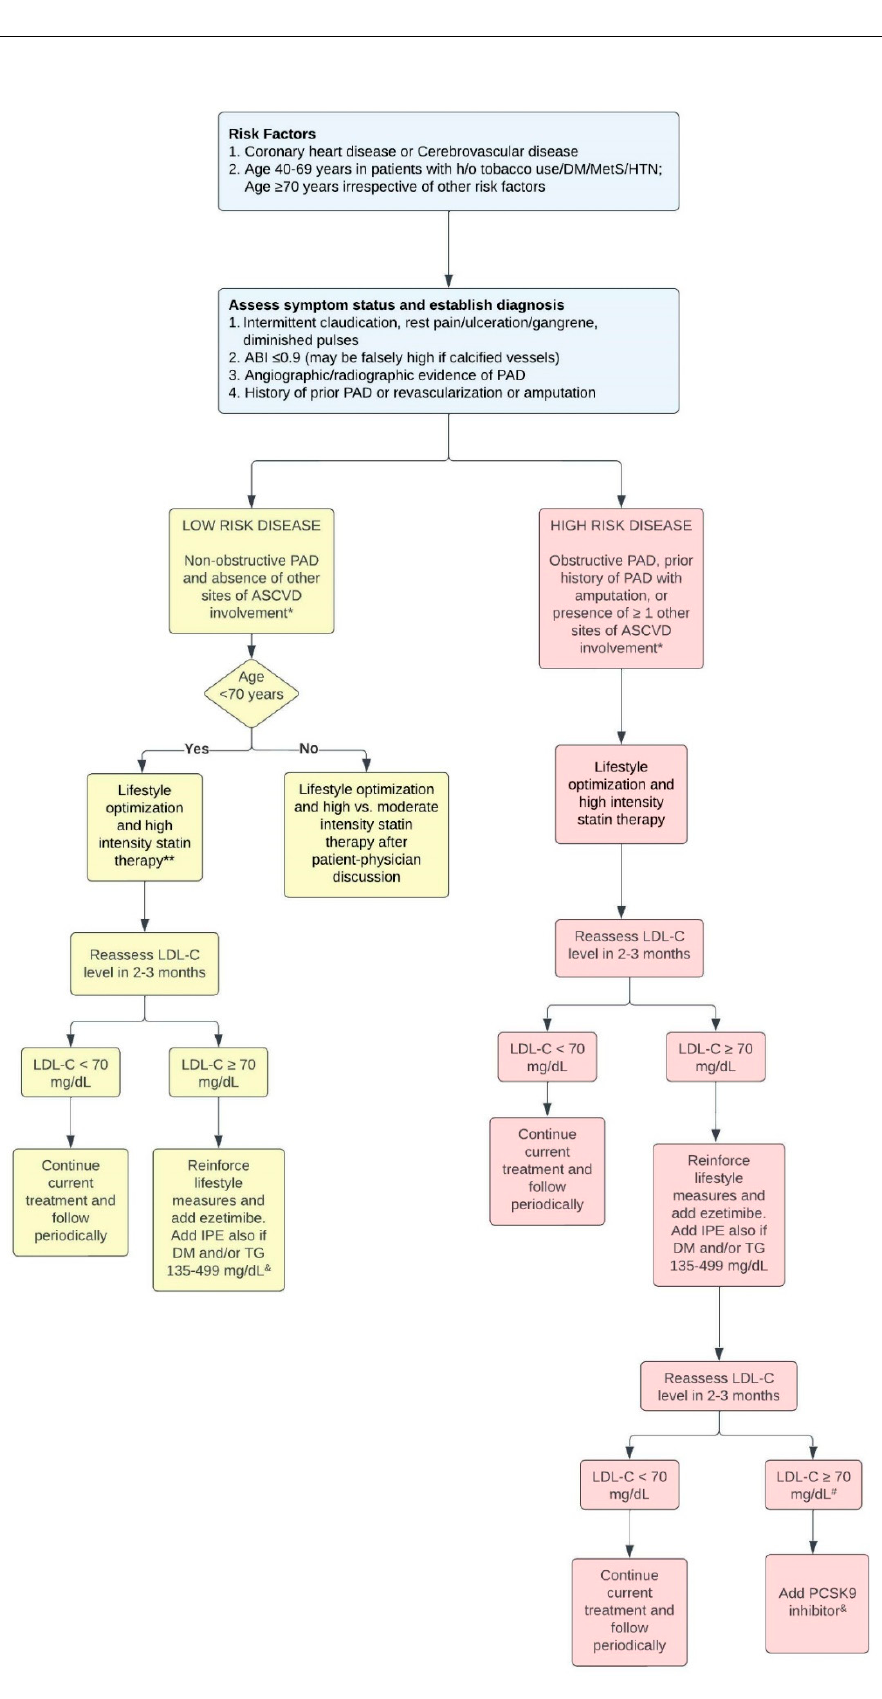
Figure 3. University of Louisville approach to PAD treatment based on current guidelines. * ASCVD disease includes CAD, PAD, TIA, stroke, history of myocardial infarction, aortic aneurysm, carotid atherosclerotic disease, history of coronary artery bypass grafting, or percutaneous coronary inter- vention. Risk factors include HTN, HLD, DM, age ≥ 70 years, LDL-C >100 mg/dL, high-sensitivity